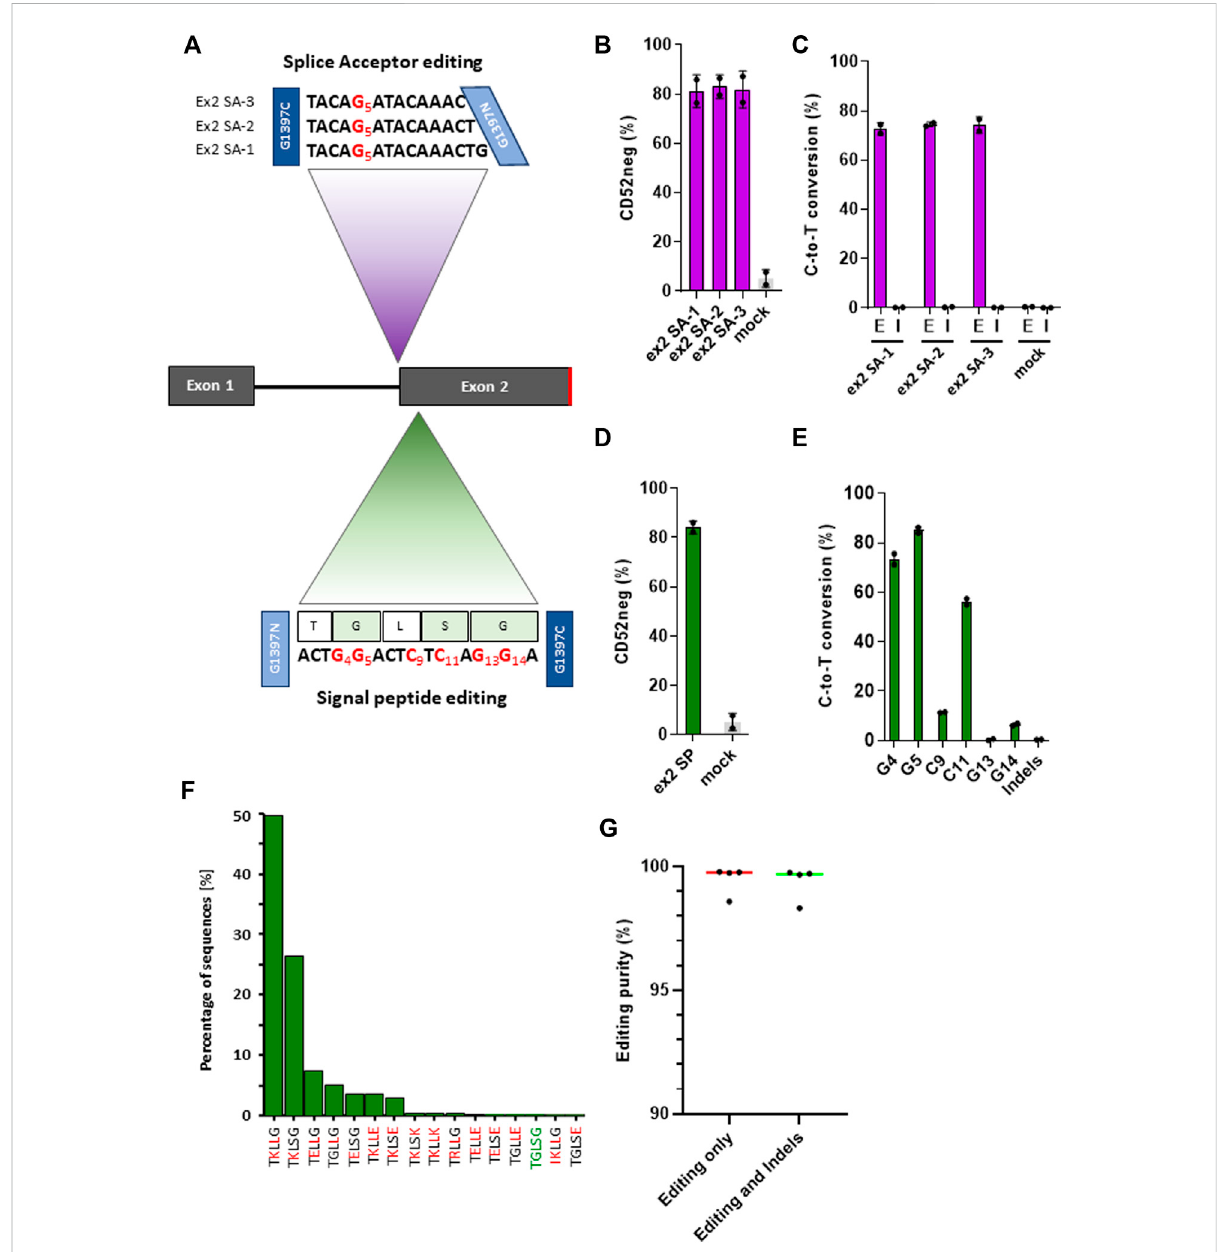
FIGURE 3 (A) . Schematic representation of target spacer sequence for TALE-BE targeting CD52. Top: TALE-BE (ex2 SA-1, two and 3) designed to edit CD52 exon2 splice acceptor site. The conserved G of the splice site, targeted by the TALE-BE) is depicted in red. Bottom: TALE-BE targeting CD52signalpeptidesequenceinexon2(SP).TALE-BEspacersequence(withtargetableCsorGsnumbered)andpeptidesequencearedepicted. (B) . CD52 negative cell frequency in the TALE-BE treated (targeting CD52 exon2 splice acceptor site) or mock electroporated PBMC populations, 6 days post electroporation, measured by fl ow cytometry. (C) . Editing (E) frequencies (C-to-T conversion) of the conserved G of the exon two acceptor splice site (Editing) and the indel (I) frequencies within the target locus, measured by NGS 6 days post transfection. (D) . CD52 negative cell frequency in the TALE-BE treated (targeting CD52 signal sequence in exon2) or mock electroporated PBMC populations, 6 days post electroporation, measured by fl ow cytometry. (E) . Editing frequencies (C-to-T conversion) at different position within the TALE-BE target spacer (CD52 signal sequence in exon2) and indel frequencies within the target locus, measured by NGS at Day 6 post transfection. (F) . Frequencies of peptide species created by the TALE-BE targeting the CD52 signal sequence in exon 2. The fi rst 16 most abundant species are presented. Mutation relativetothenativesignal peptideareinred.( N =2,independentT-cellsdonors). (G). Editingpurity withinthecellpopulation.Aggregateofthefour TALE-BE targeting CD52. Left: C-to-T conversion within the C-to-A/G/T population. Right: C-to-T conversion within the C-to-A/G/T + Indels population. For all panels: N = 2, independent T-cells